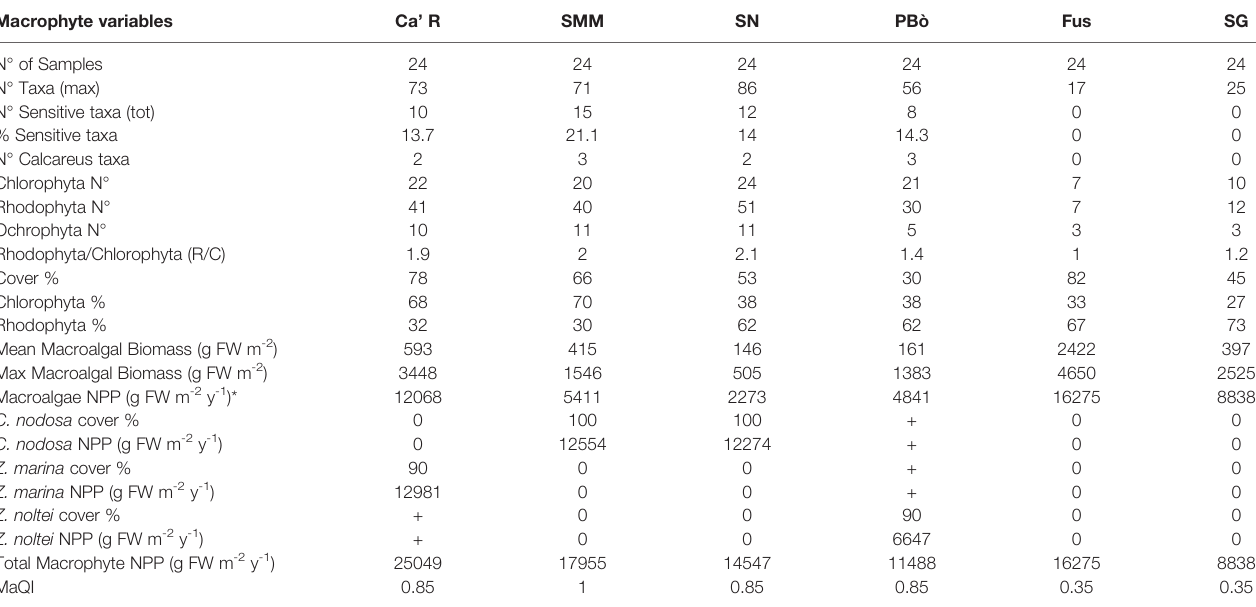
TABLE 1 | Macrophyte